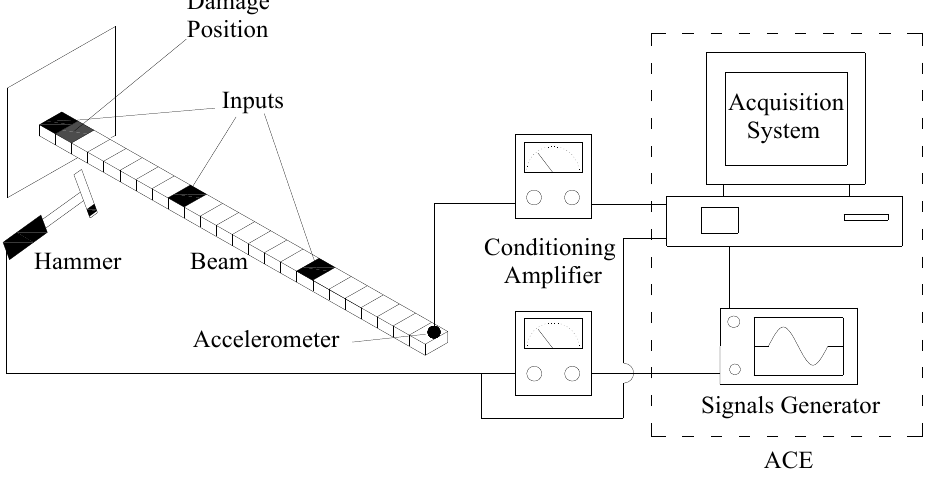
Fig. 8. Experimental setup used for damage location using the controllability